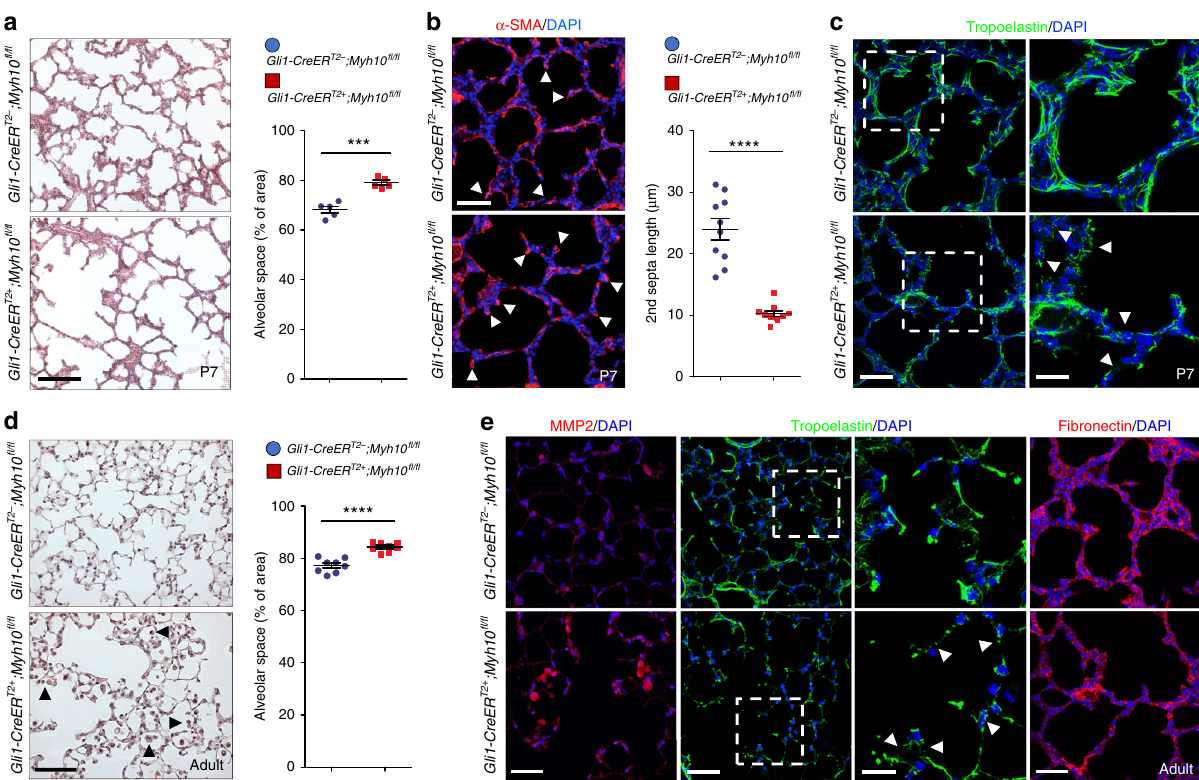
Fig. 6 Myh10 de fi ciency causes emphysema-like phenotypes. a H&E staining of wild-type ( n = 10) and Gli1-Myh10 cKO ( n = 8) P7 lungs. Quanti fi cation of alveolar space in wild-type and Gli1-Myh10 cKO P7 lungs. b Immunostaining for α -SMA in wild-type ( n = 10) and Gli1-Myh10 cKO ( n = 8) P7 lungs. Arrows point to secondary septae. Quanti fi cation of secondary septae length in wild-type and Gli1-Myh10 cKO P7 lungs. c Immunostaining for Tropoelastin in wild- type ( n = 10) and Gli1-Myh10 cKO ( n = 8) P7 lungs. Arrowheads point to truncated elastin fi bers. d H&E staining and morphometric analysis of alveolar space in wild-type ( n = 8) and Gli1-Myh10 cKO ( n = 6) adult lungs. Arrowheads point to macrophages. e Immunostaining for MMP2, tropoelastin, and fi bronectin in wild-type ( n = 8) and Gli1-Myh10 cKO ( n = 6) adult lungs. Arrowheads point to truncated elastin fi bers. Error bars are means± s.e.m. *** P < 0.001, **** P < 0.0001, two-tailed Student ’ s t -test. Scale bars: 50 μ m ( a , d ), 30 μ m ( b , c (left), e (left, right)), 15 μ m ( c (right), e